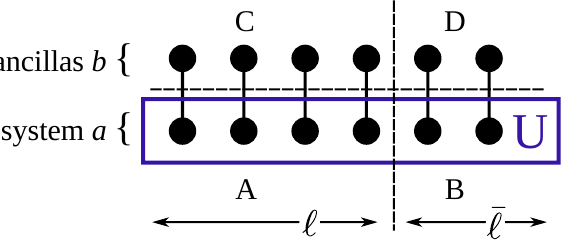
Figure 3 . Pictorial representation for the state and upper rows represent the original and \replica" fermions a is a maximally entangled pair, which corresponds to the vacuum for the complex Fermi operators c j = a i b . The evolution operator U , generated by the Hamiltonian (2.1), is applied only to j (cid:0) j the original